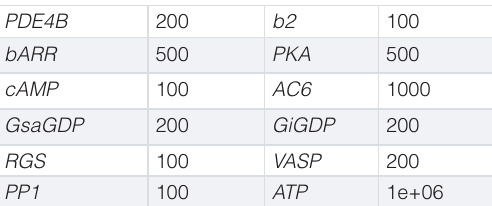
Table 2. Initial concentrations (in nM) of species in the sample system.